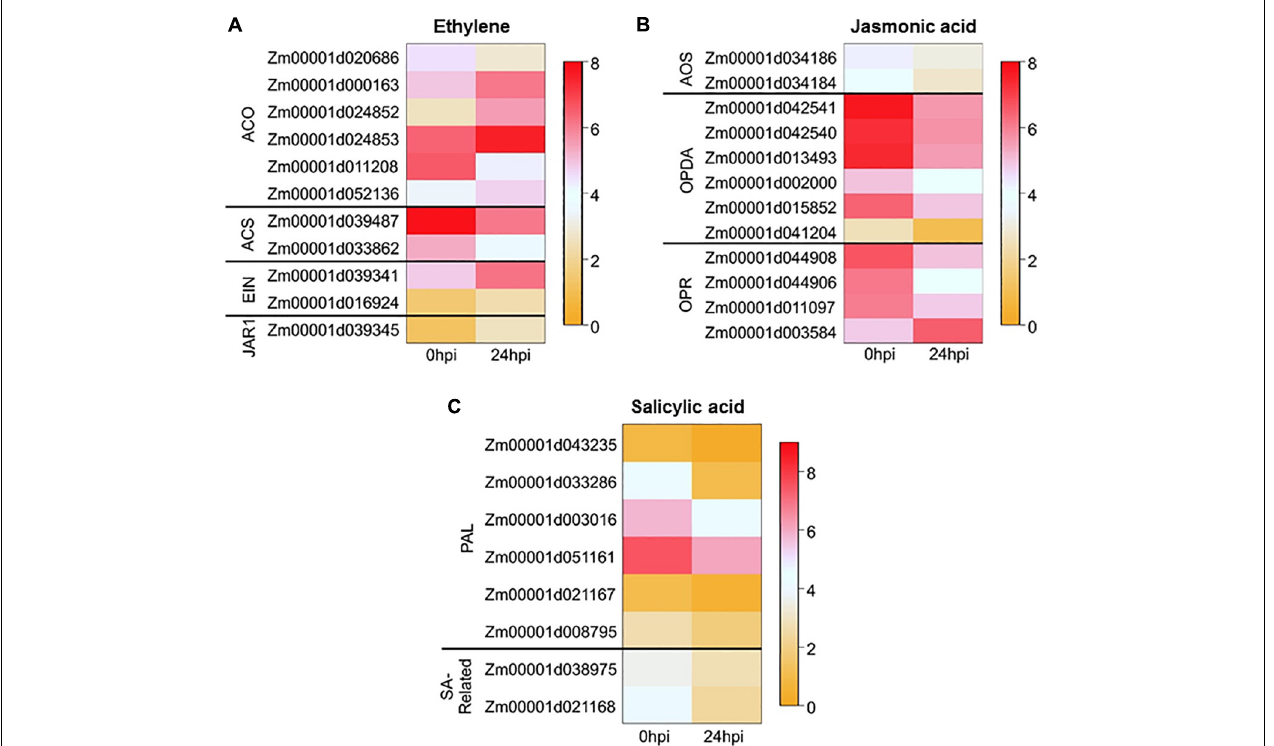
FIGURE 4 | Heatmap of the expression ECB feeding-induced genes involved in different hormone pathways: (A) ethylene, (B) jasmonic acid, and (C) salicylic acid. For the columns Mp708_0 hpi and Mp708_24 hpi, each cell contains the relative expression level [log 2 (FPKM + 1)].